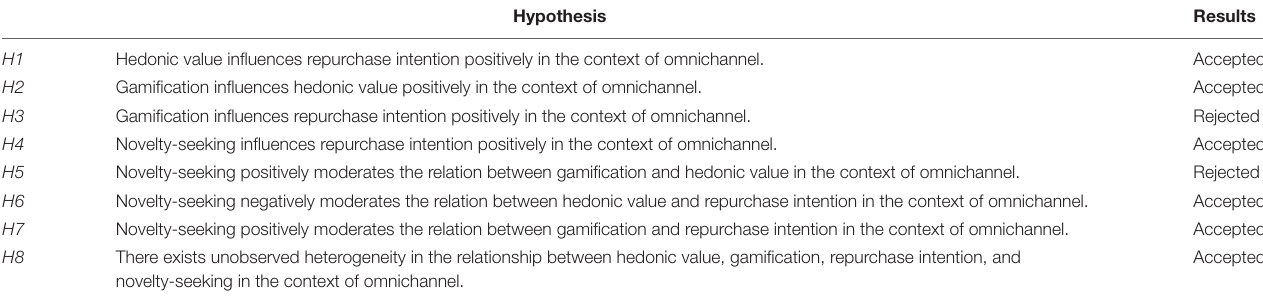
TABLE 11 | Overall results of hypotheses tests.